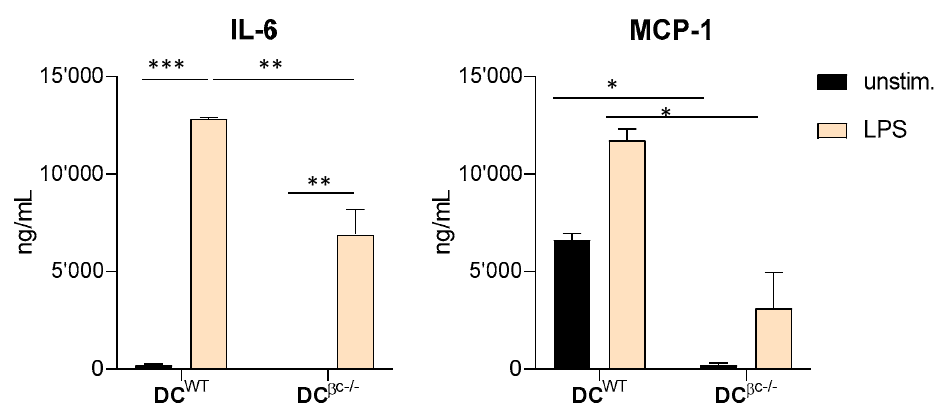
Figure 3. The IL-6 and MCP-1 production by DC β c-/- is decreased compared to DC WT . DC WT and DC β c-/- were stimulated during two days with LPS. The IL-6 and MCP-1 concentration in supernatants were then quantified with a BD™ CBA (Cytometric Bead Array) Mouse Inflammation Kit and analyzed by flow cytometry. The graphs are the cumulative results of the two experiments (the black bar is the non-stimulated condition, and the grey bar is the LPS stimulation). Differences regarded as statistically significant between the groups are presented as follows: * p < 0.05, ** p < 0.01, *** p < 0.001 and **** p < 0.0001.